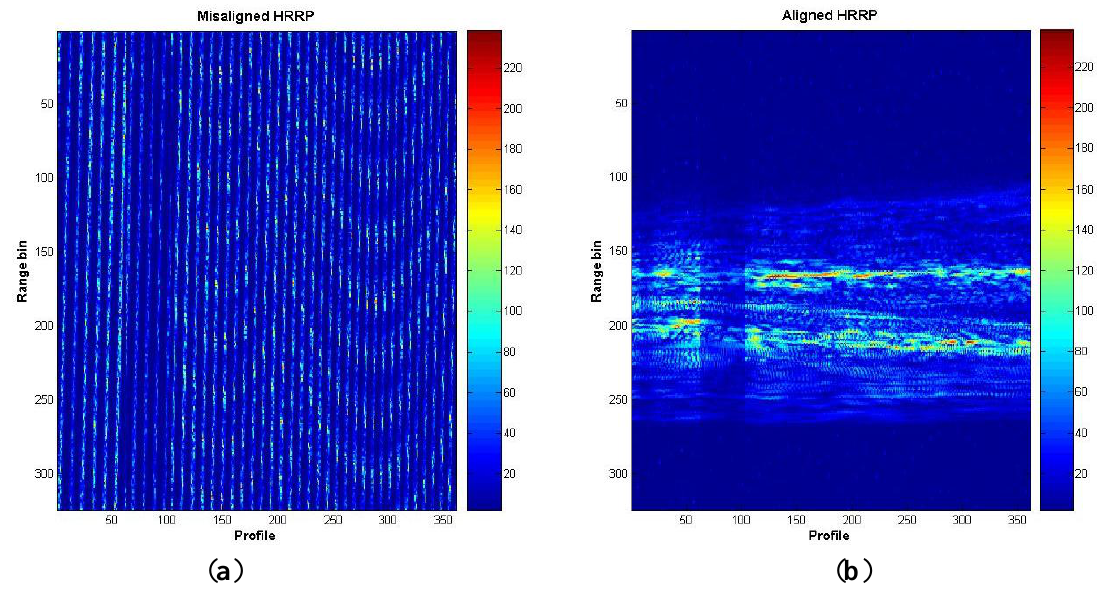
Figure 9. Profile alignment process—2D; ( a ) initially misaligned HRRP; ( b ) aligned HRRP after translational motion compensation.